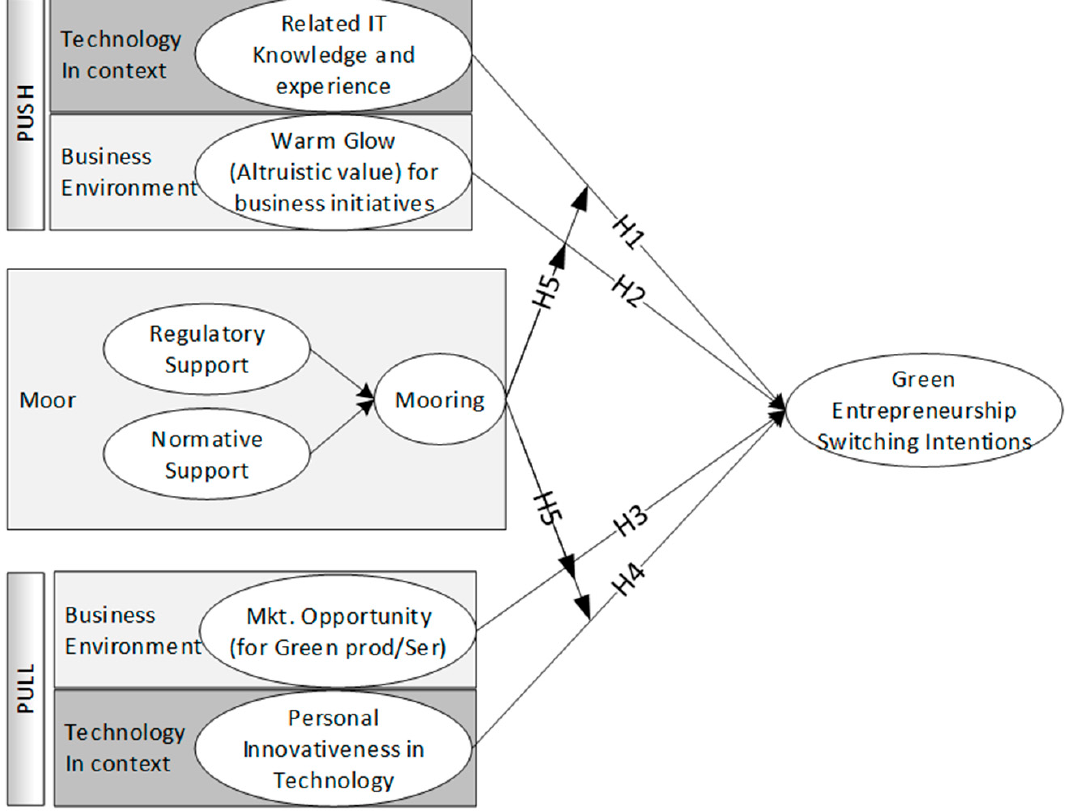
Figure 1. Graphical presentation of the proposed model.